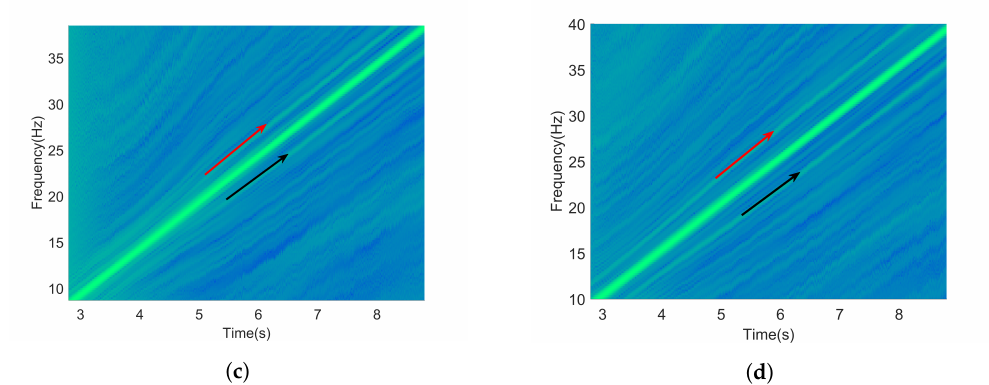
Figure 5. Time-frequency distributions of the stator current for the following cases: ( a ) Healthy motor under low load; ( b ) Healthy motor under high load; ( c ) Motor with one broken rotor bar under low load; ( d ) Motor with one broken rotor bar under high load.